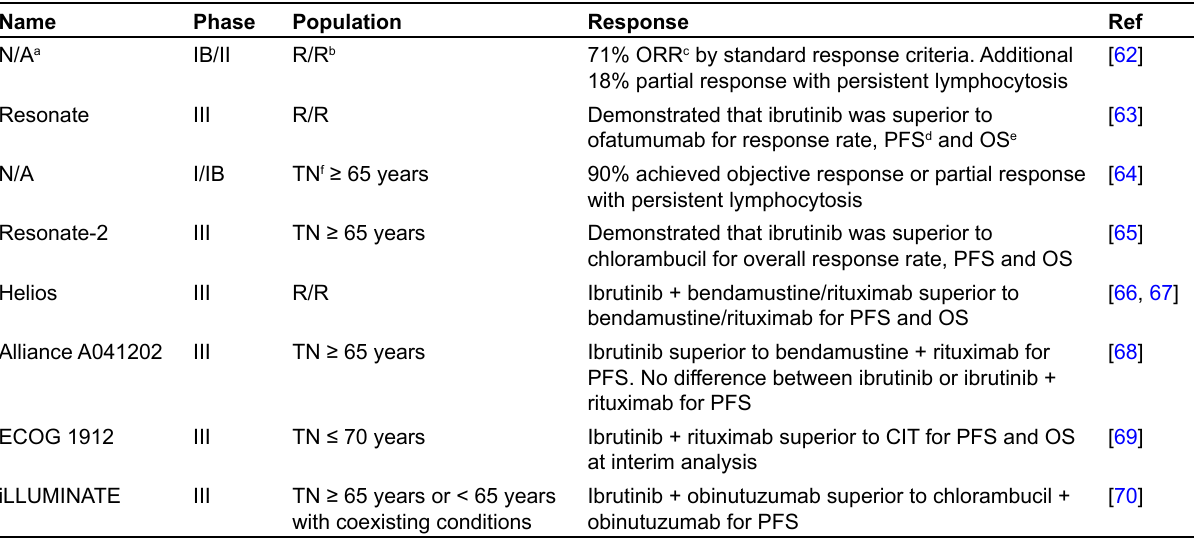
Table 1. Key clinical trials with ibrutinib in CLL